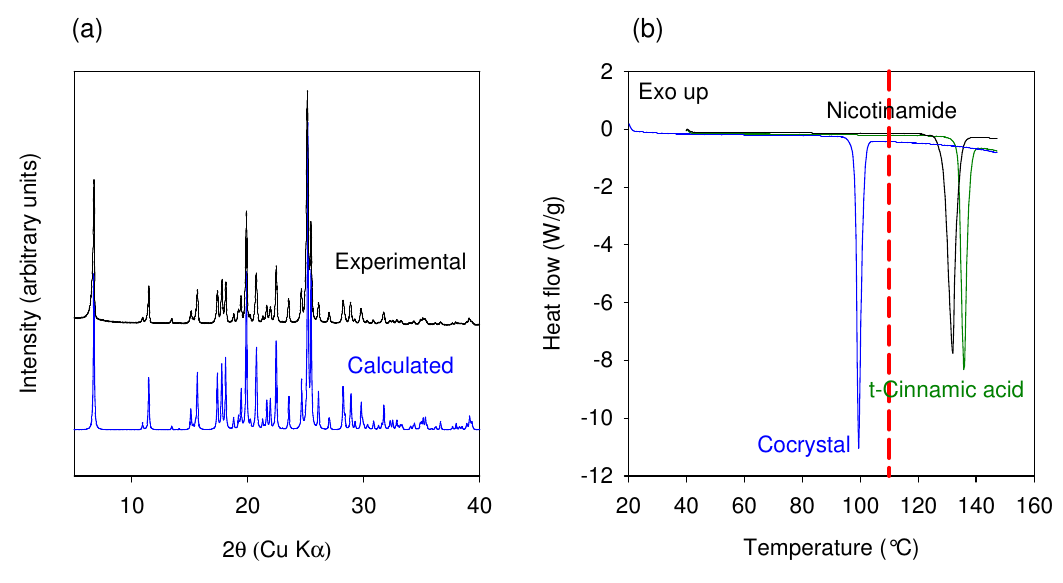
Figure 8. ( a ) Comparison of experimental and calculated XRPD profiles of Nicotinamide- trans Cinnamic acid cocrystal. ( b ) DSC thermogram showing comparison of trans cinnamic acid, Nicotinamide and the 1:1 Nicotinamide-trans Cinnamic acid cocrystal. The dotted line in Figure (b) represents the extrusion